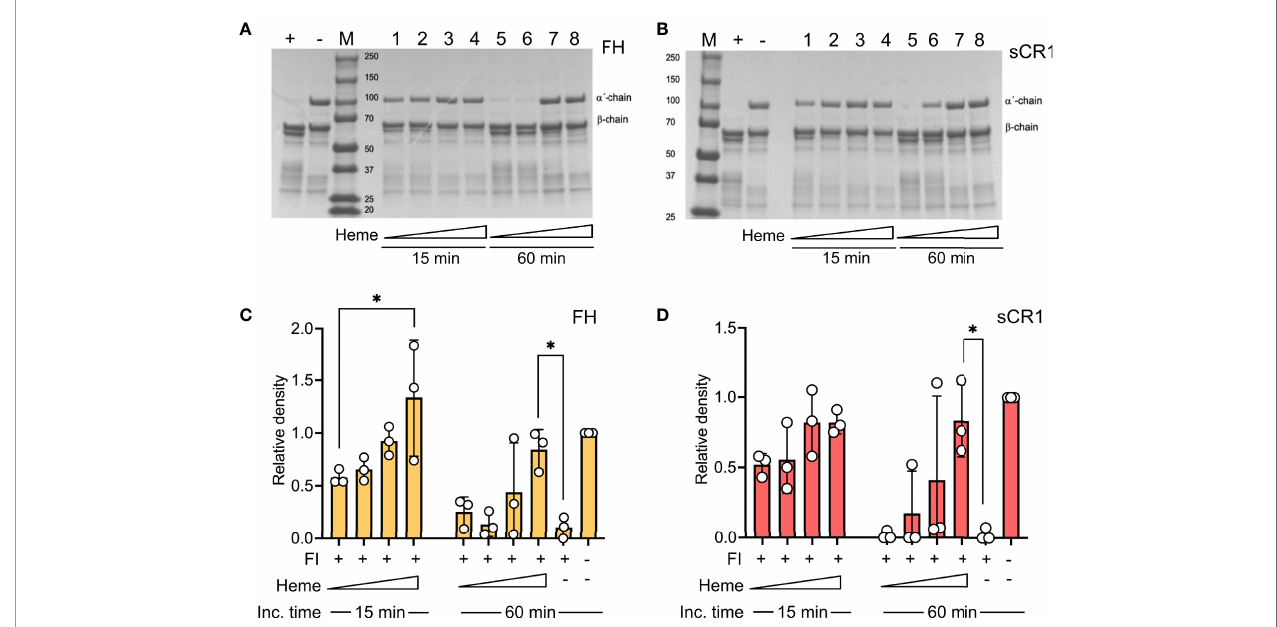
FIGURE 2 | Effect of heme on factor I-mediated degradation of soluble C3b. C3b (10 m g) was incubated in the presence of factor I (FI, 0.1 m g) and (A, C) factor H (FH, 0.1 m g) or (B, D) soluble complement receptor 1 (sCR1, 0.1 m g) at 37°C for 15 and 60 minutes, in phosphate buffered saline (PBS) pH 7.4. The samples were run on a 4-15% SDS-PAGE under reduced conditions and stained with Coomassie Brilliant Blue. The gels shown (A, B) are each a representative gel from three independent experiments. (A, B) The samples are displayed as follows: positive control (+); negative control, which lacks FI (-); molecular weight marker (M). For samples 1-8, heme was included in increasing concentrations (lane 1, 5: 8 m M; lane 2, 6: 16 m M, lane 3, 7: 32 m M, lane 4, 8: 64 m M) for 15 minutes (1-4) or 60 minutes (5-8), as indicated in the fi gure. (C, D) C3b-degradation was evaluated by densitometric measurement and displayed as the relative density of the C3b intact a ´-chain at 101 kDa in relation to the b -chain at 75 kDa. The values are shown as mean +/- standard deviation of n=3. *p <